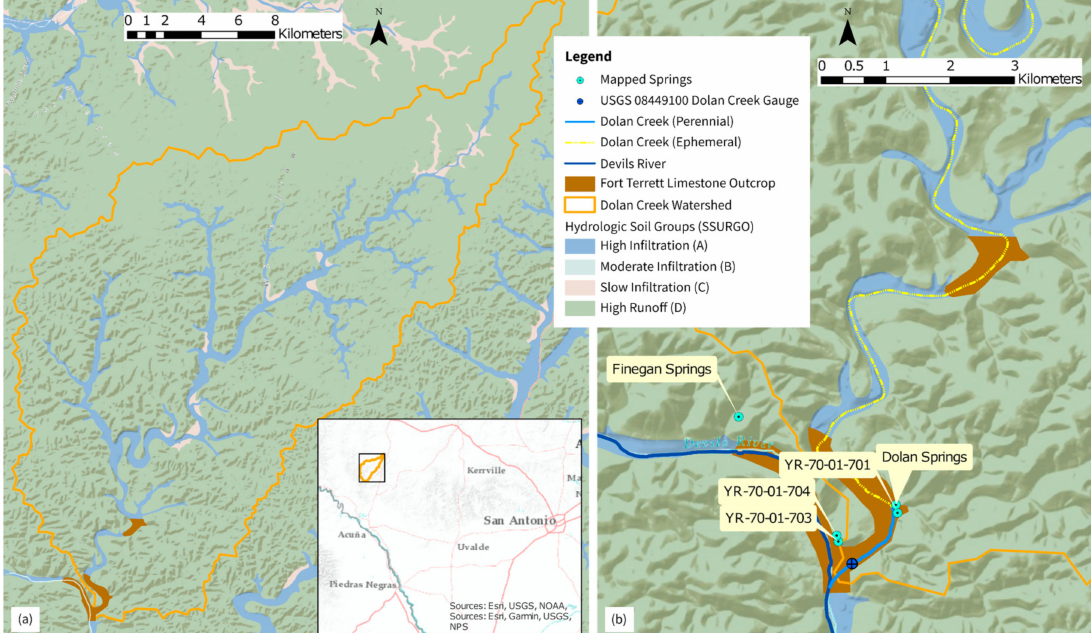
Figure 2. Study watershed location and hydrologic characteristics from Soil Survey Geographic Database (SSURGO) [22]. ( a ) shows the site location and watershed extent, ( b ) provides a close-up of the watershed outlet including locations of mapped springs and United States Geological Survey (USGS) 08449100 Dolan Creek Gauge. The North American Datum of 1983 (NAD83) coordinates of USGS 08449100 are 29.888 degrees latitude and 100.990 degrees longitude. Adapted from Martin [19] CC BY